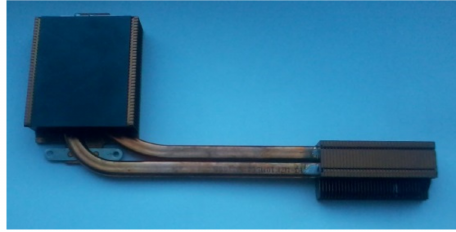
Figure 1. Photo of the active heat